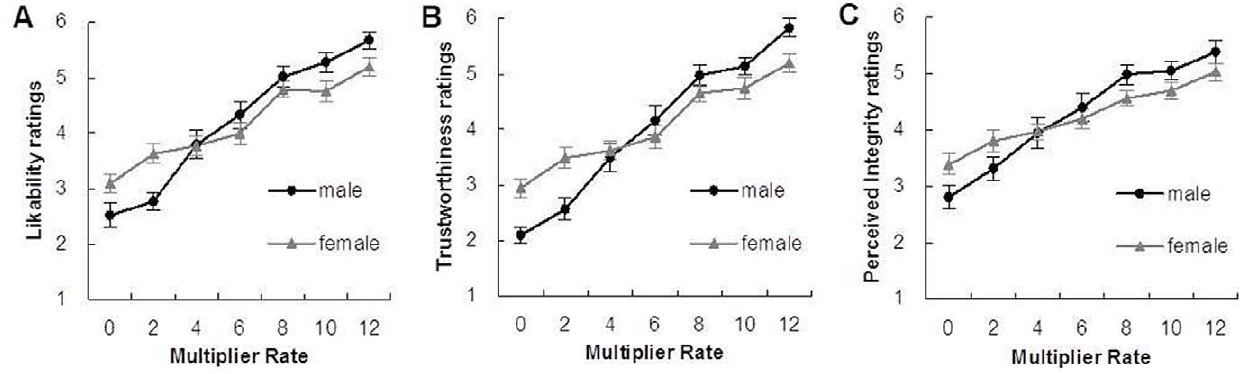
Figure 3. Partner judgments in three dimensions in post-game test on the 7-point Likert-type scale. Graphs show the mean 6 SEM. (A) Likability ratings. (B) Trustworthiness ratings. (C) Perceived integrity ratings.